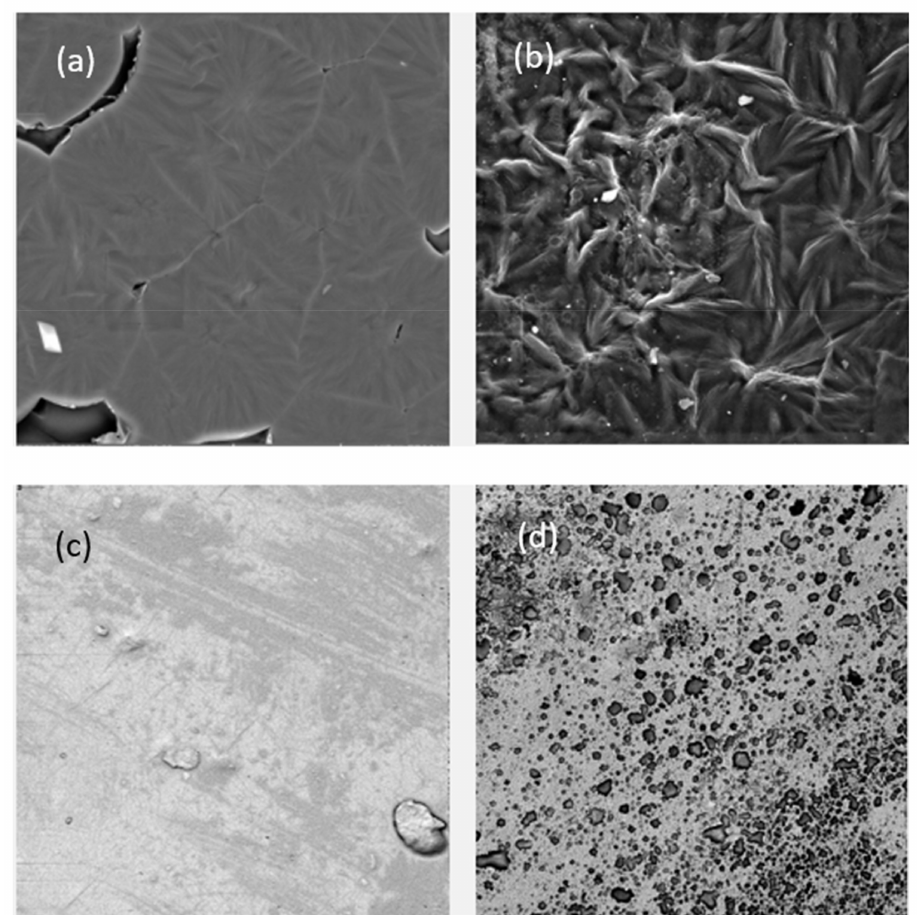
Figure 5. SEM images of: ( a ) PCL, ( b ) TSNP/PCL, ( c ) PLA, and ( d ) TSNP/PLA films (1000 ×